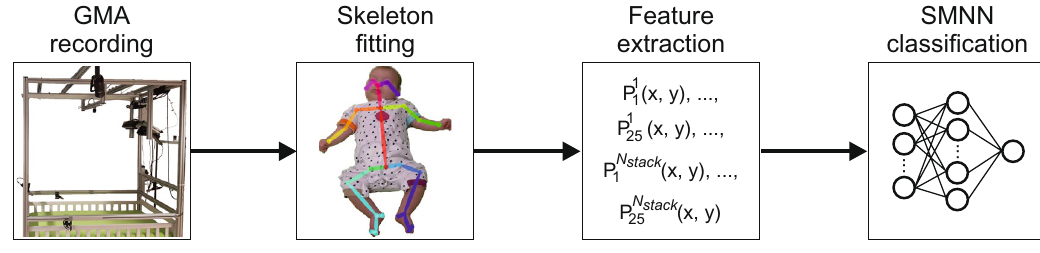
Figure 1. Overview of the algorithm’s process